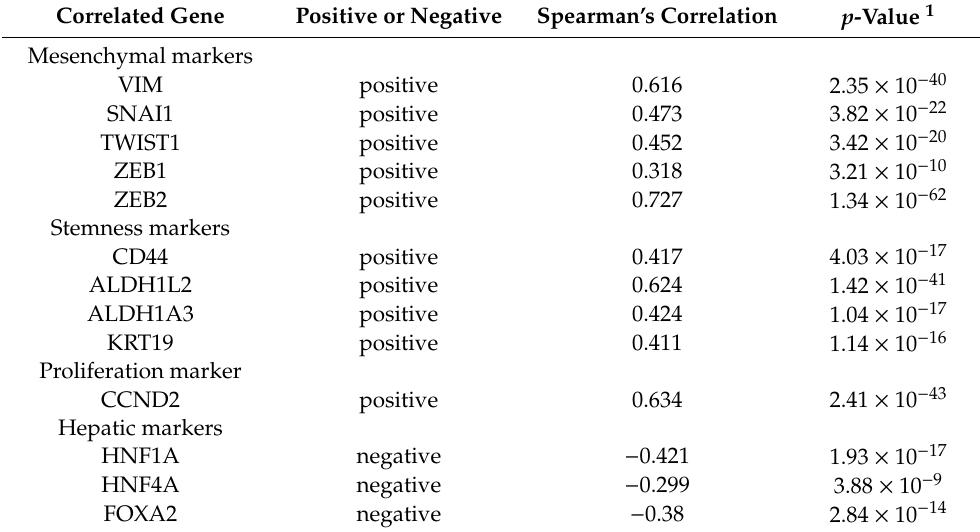
Table 1. List of genes correlated with HDAC9 expression in 373 HCC samples in the The Cancer Genome Atlas (TCGA)